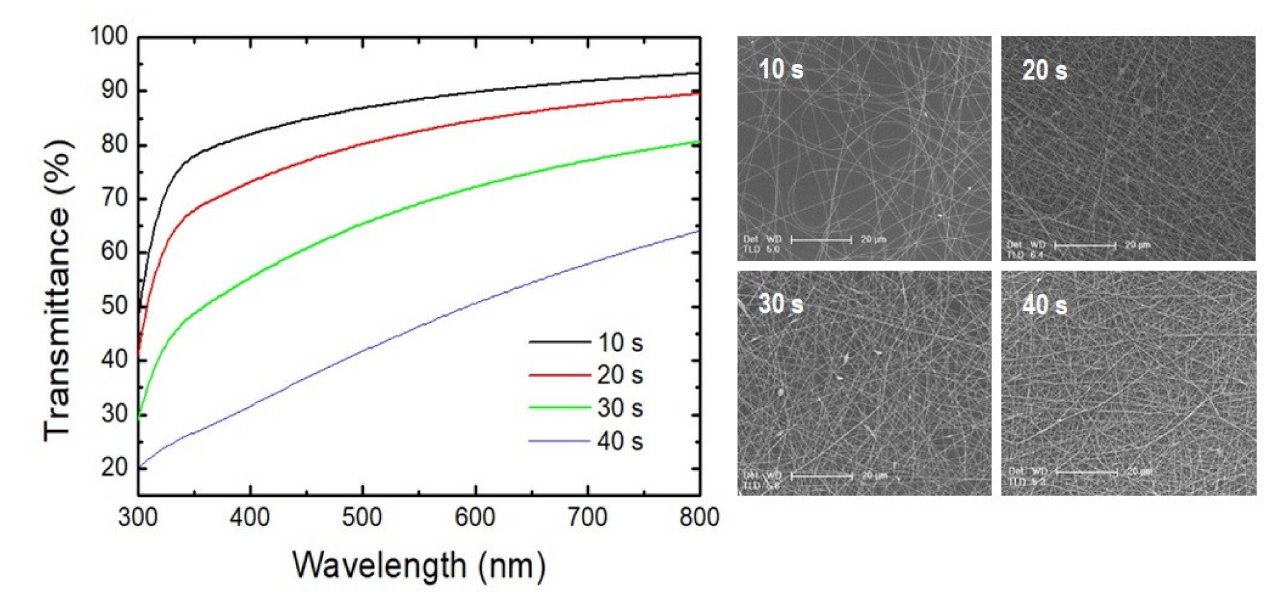
Figure 4. ( Left ) Transmittance spectra of randomly distributed PS fibers deposited with deposition times of 10 s, 20 s, 30 s, and 40 s. ( Right ) SEM images of the random networks of PS fibers.